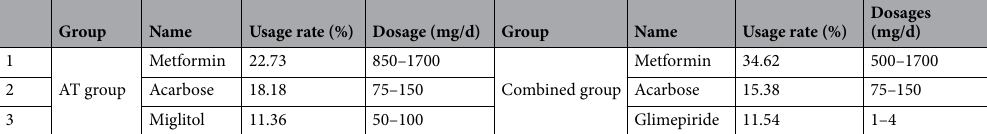
Table 5. The antidiabetic drug use and dosages in different groups. A: antidepressants. S: mood stabilizers. SGA: atypical antipsychotics. PT group: psychotropics treatment group. Combined group: combined treatment group. AT group: antidiabetics treatment